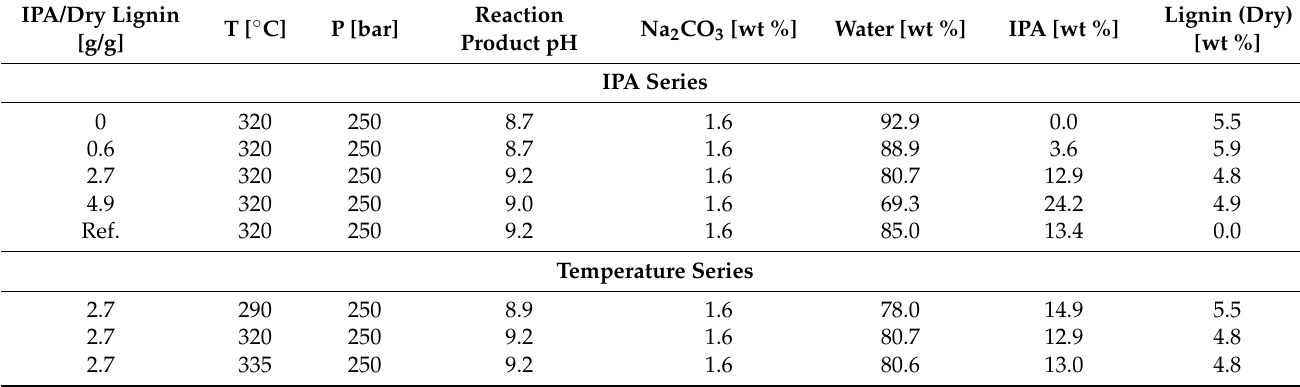
Table 1. Experimental conditions and compositions of the reaction mixture. The experiment at 320 ◦ C, 2.7 IPA/lignin was used in both